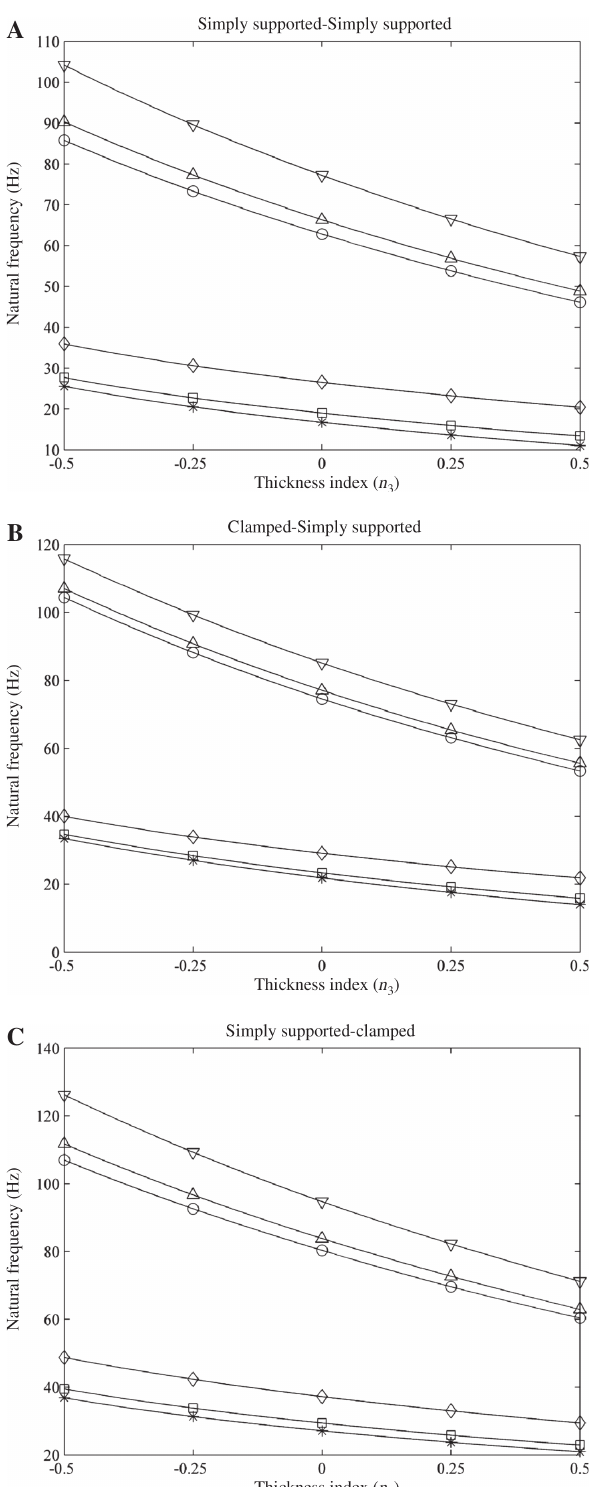
Figure 5 Effects of a/b variations on the natural frequency of the isotropic disc for C-C boundary conditions. * ( m = 0; n = 1), ○ ( m = 0; n = 2), □ ( m = 1; n = 1), ∆ ( m = 1; n = 2), ◊ ( m = 2; n = 1), ∇ ( m = 2; n =